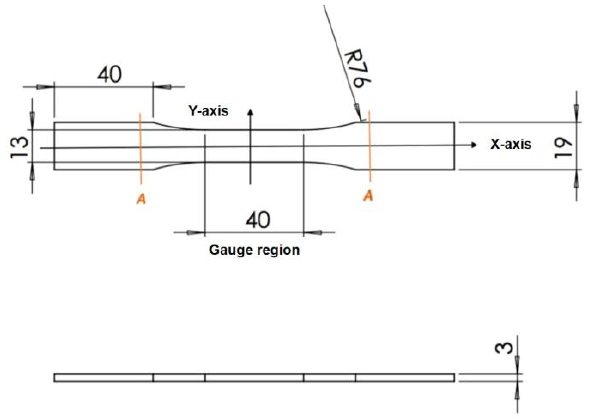
Figure 5. Specimen dimensions. Figure 5. Specimen